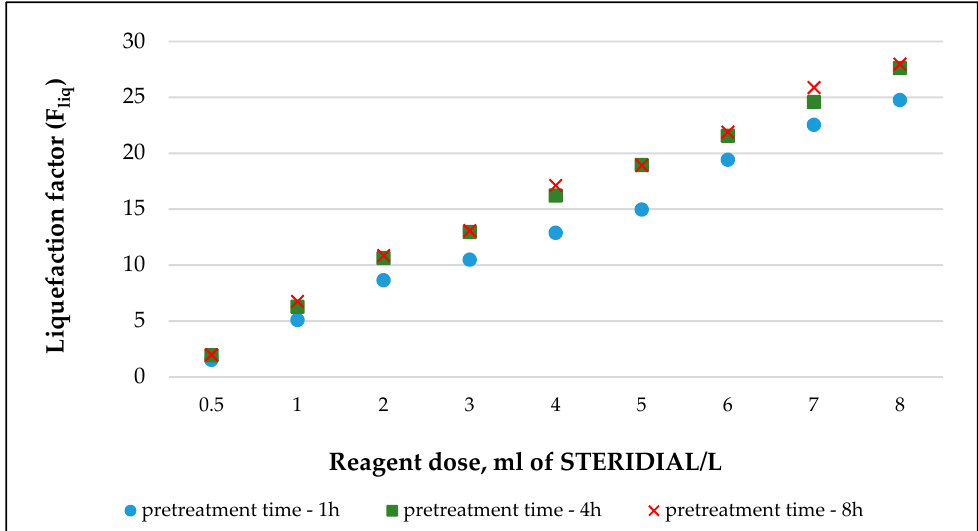
Figure 8. Changes in the value of the liquefaction factor determined in the supernatant liquid of chemically disintegrated excess sludge (pretreatment time 1, 4, and 8 h). Due to the technological conditions of the anaerobic stabilization process, a reagent dose of 3.0 mL of STERIDIAL W-10/L of sludge was selected for further experiments, for which, along with the subsequent increase in sludge biodegradability, there was no need to modify the pH of the sludge treated. In the case of higher doses, a correction of the pH value would be necessary and would cause secondary contamination of the treated medium. The reagent dose of 3 mL of STERIDIAL W-10/L, and the pretreatment time of